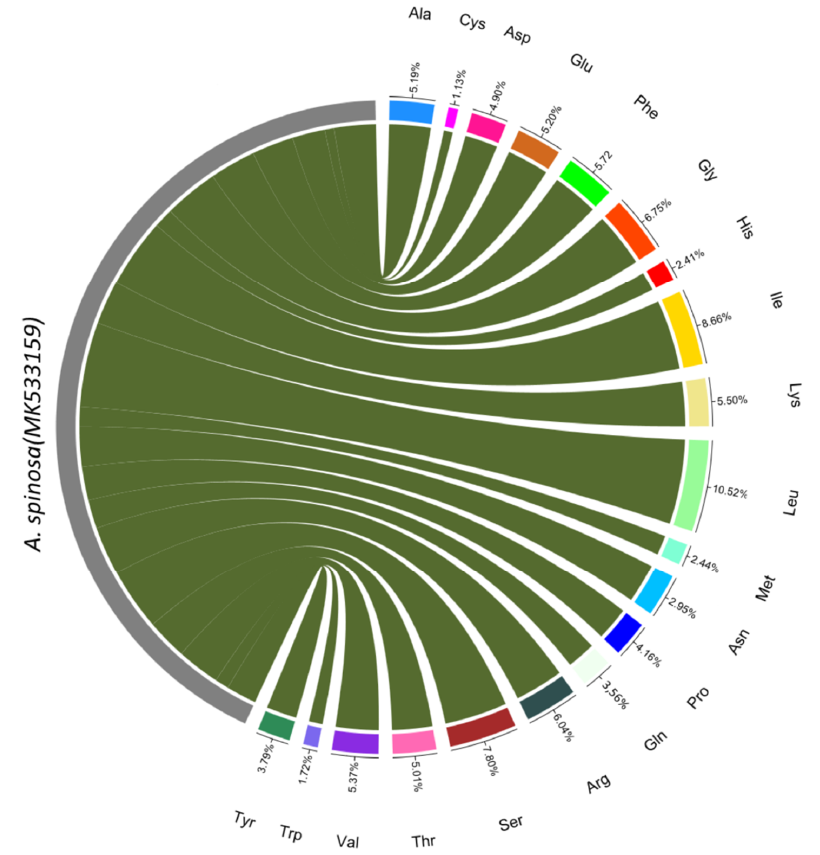
Figure 2. Amino acid frequencies of the A. spinosa chloroplast protein-coding sequences. The frequencies of amino acids were calculated for all 85 protein-coding genes from the start to the stop codons.